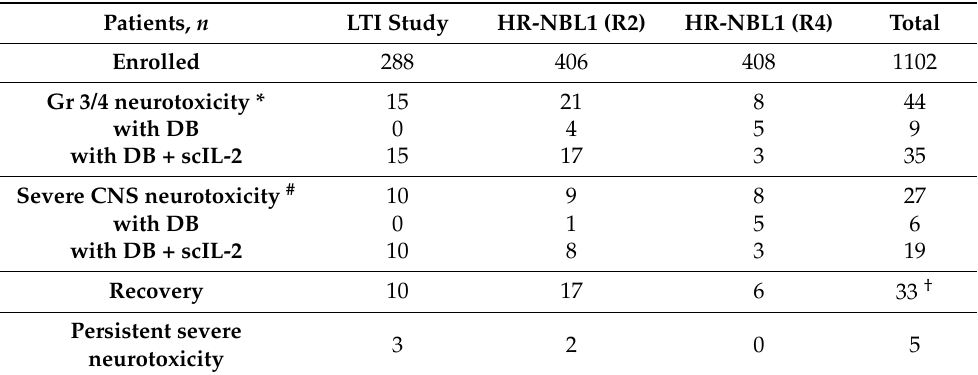
Table 2. Distribution and outcome of patients with severe neurotoxicity in the LTI and HR-NBL1 (R2 and R4)